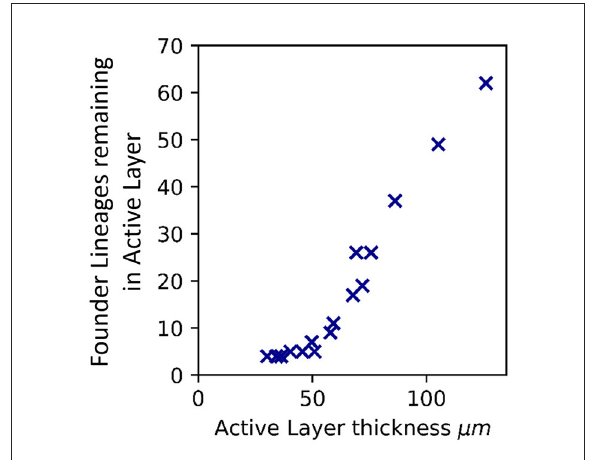
FIGURE2 Active layer thickness controls loss of standing diversity. Correlation between the number of founder lineages remaining in the active layer, and thickness of the active layer (averaged across the biofilm interface), for 16 simulated biofilms of size 50,000 microbial agents. The active layer thickness was varied by changing the bulk nutrient concentration ( S bulk ) and the maximum specific growth rate ( µ max ). The values of S bulk and µ max corresponding to these simulations are shown in Supplementary table 1 together with the active layer thicknesses. The rest of the simulation input parameters are as in Table 1. Supplementary figure 3 shows the same plot for biofilms that have reached 25,000, 75,000, and 100,000 microbial